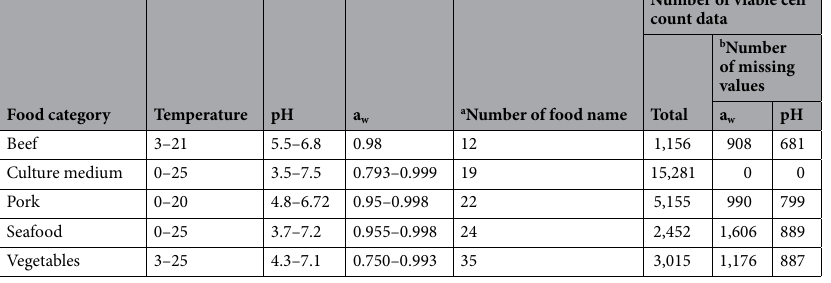
Table 1. Summary of the extracted data from ComBase. a Number of Food Name: number of specific food name. (The entire list of Food Name can be found as Supplementary Data S2 online). b Number of Missing values: number of data lacking a w or